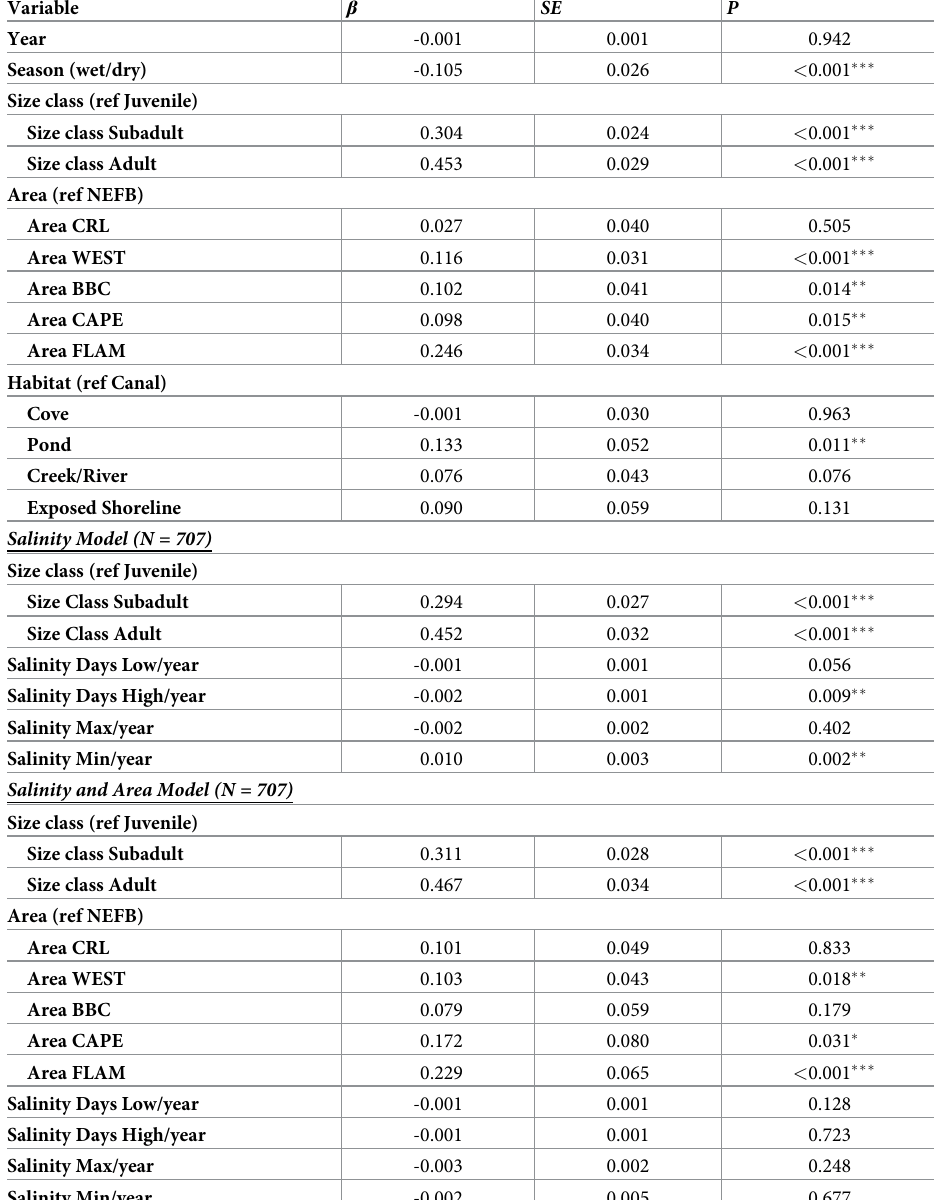
Table 1. Multivariate linear regression analysis of body condition of American crocodiles ( Crocodylus acutus ) captured in South Florida from